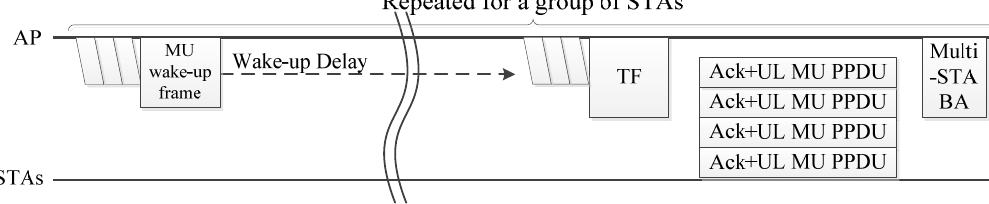
Figure 9. Normal uplink multiuser transmission using wake-up packet for multiple user.